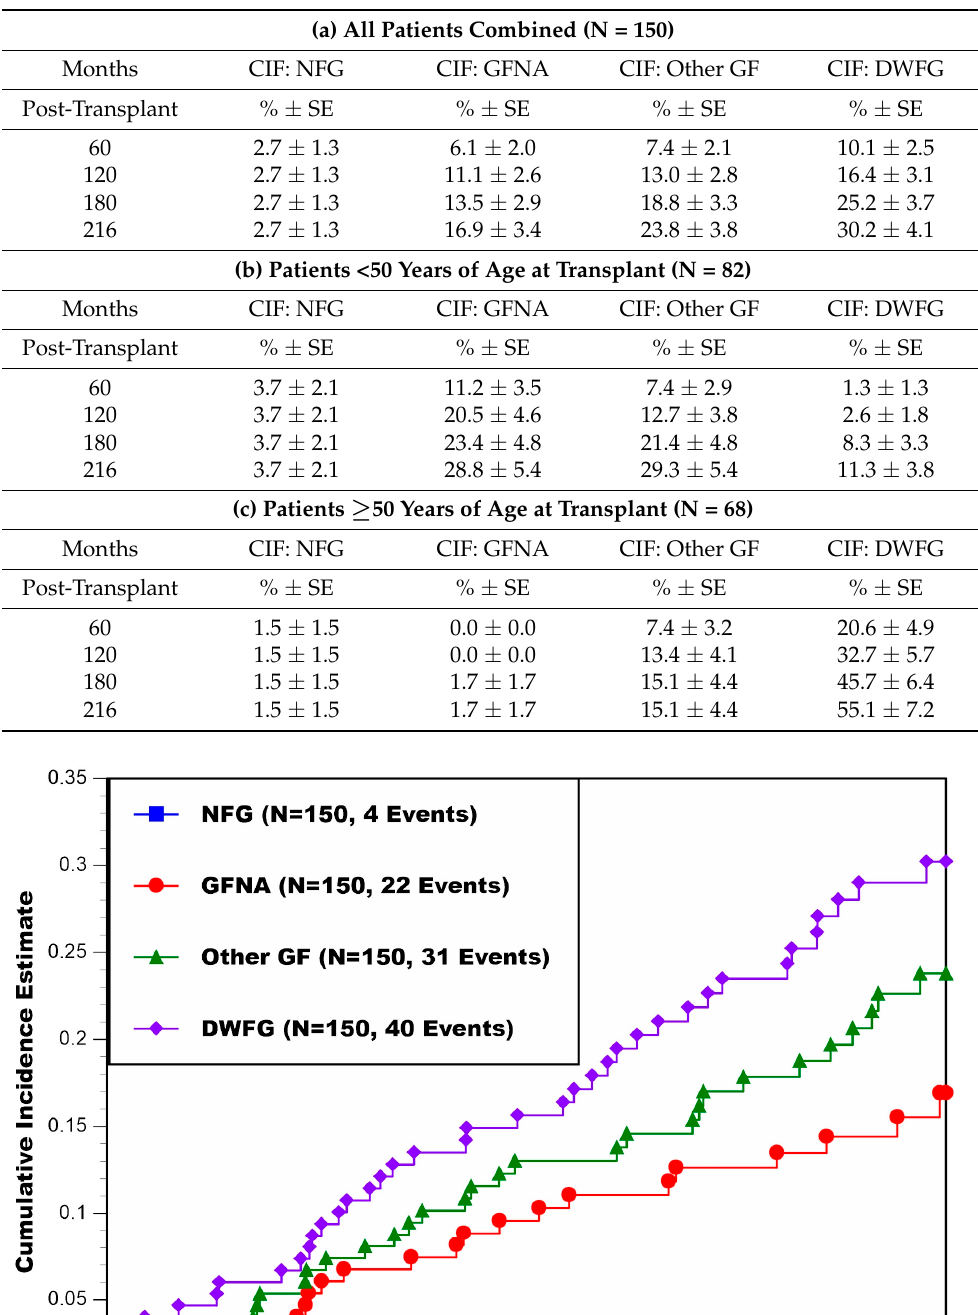
Table 2. Cumulative incidence function (CIF) estimates of the percentages experiencing cause-specific graft loss.